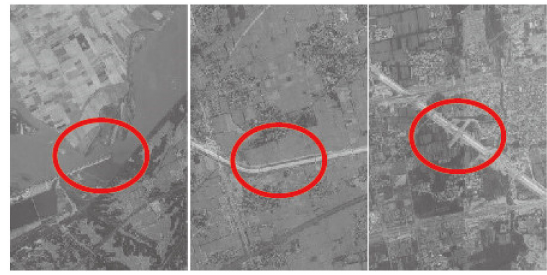
Figure 15. Zoomed Views of Mosaic